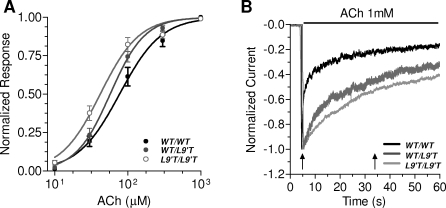
Hypersensitive and Slowly Desensitizing ACh Responses(A) Concentration-response curves to ACh performed in P9–P10 IHCs. Peak current values were normalized and referred to the maximal peak response to ACh in each case. The mean and S.E.M. of experiments performed in n = 7 cells (4 animals) for Chrna9wt/wt, 9 cells (4 animals) for Chrna9wt/L9′T, and 7 cells (4 animals) for Chrna9L9′T/L9′T are shown; (B) Wave-form of responses to ACh in P6–P10 IHCs voltage-clamped at −90 mV. Representative responses to the application of 1 mM ACh during 1 min are shown. WT, wild type.